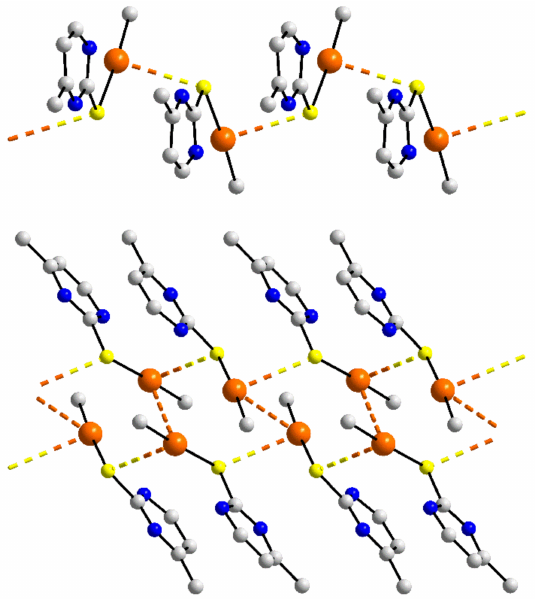
Figure 15. Supramolecular association in the crystal of 44 : upper view—zigzag chain featuring Hg ··· S interactions; lower view—double chain formation through the agency of Hg ··· Hg interactions shown as orange dashed lines.